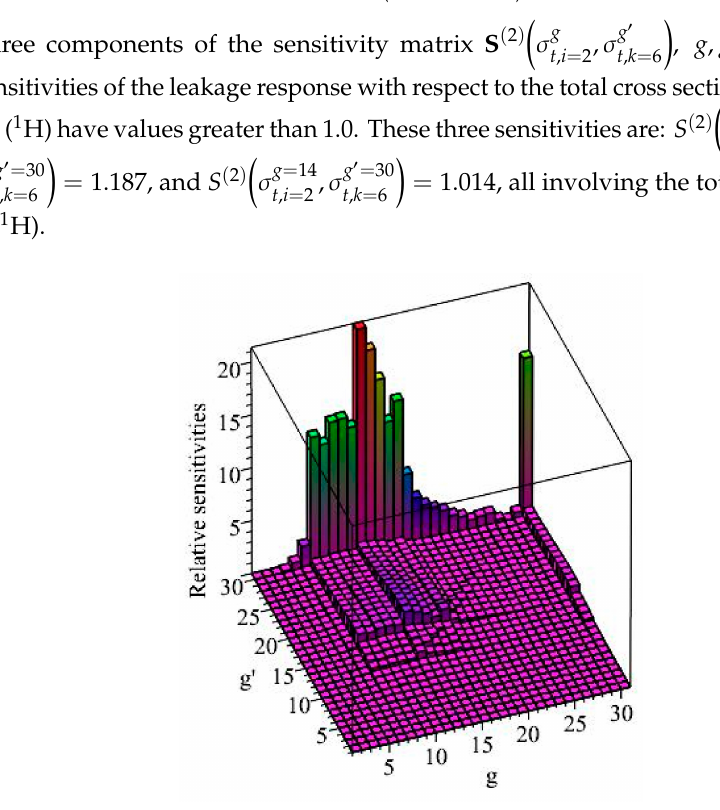
Figure 3. The matrix of sensitivities S ( 2 )